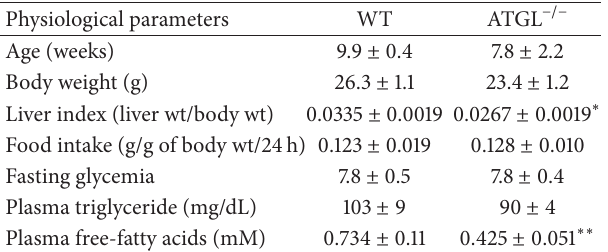
Table 2: Glucose appearance and Cori cycling fluxes in WT and ATGL − / − mice based on plasma glucose 13 C-isotopomer analysis. Data are expressed as mean ±